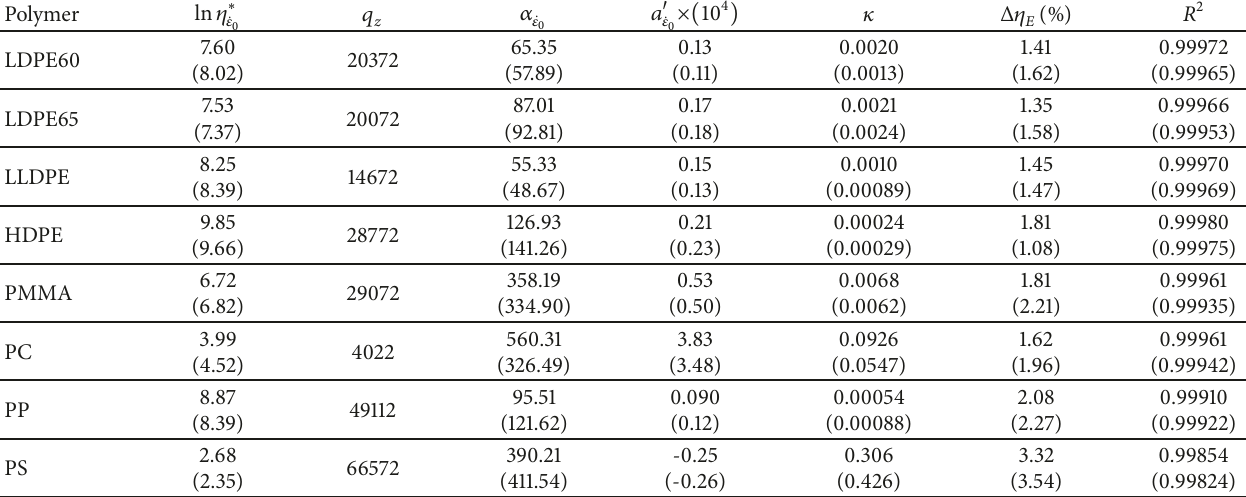
Table 2: Values of parameters of (7) evaluated for 𝜂 0 at zero level of elongational rate according to (5) and (6) in brackets.